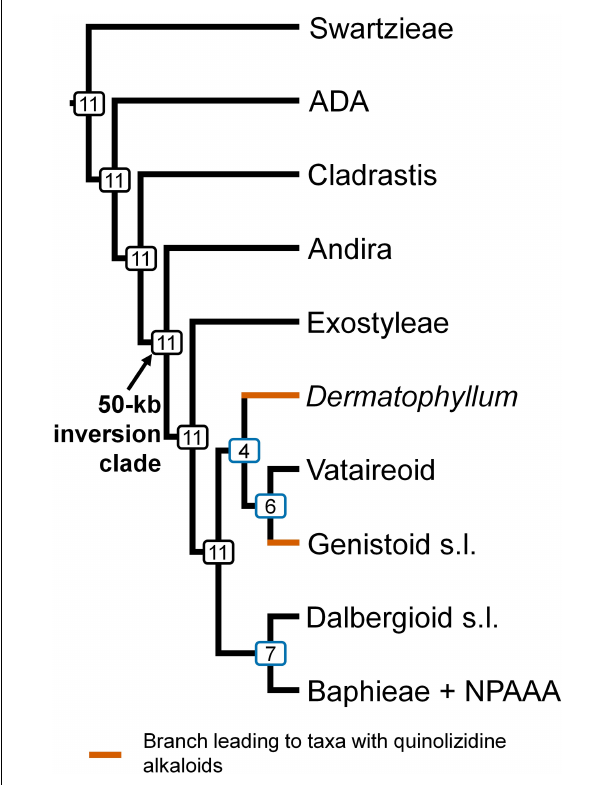
FIGURE 3 | The consensus of 11 phylogenetic trees of papilionoid legumes based on analyses of plastome-scale and matK sequence data. The number of topologies in which this clade was recovered in 11 trees is indicated at each node. Branches leading to taxa known to produce quinolizidine alkaloids are highlighted in brown. NPAAA: non-proteinogenic amino acid accumulating, ADA: Angylocalyceae, Dipterygeae, and Amburaneae, kb: kilobase, s.l.: sensu